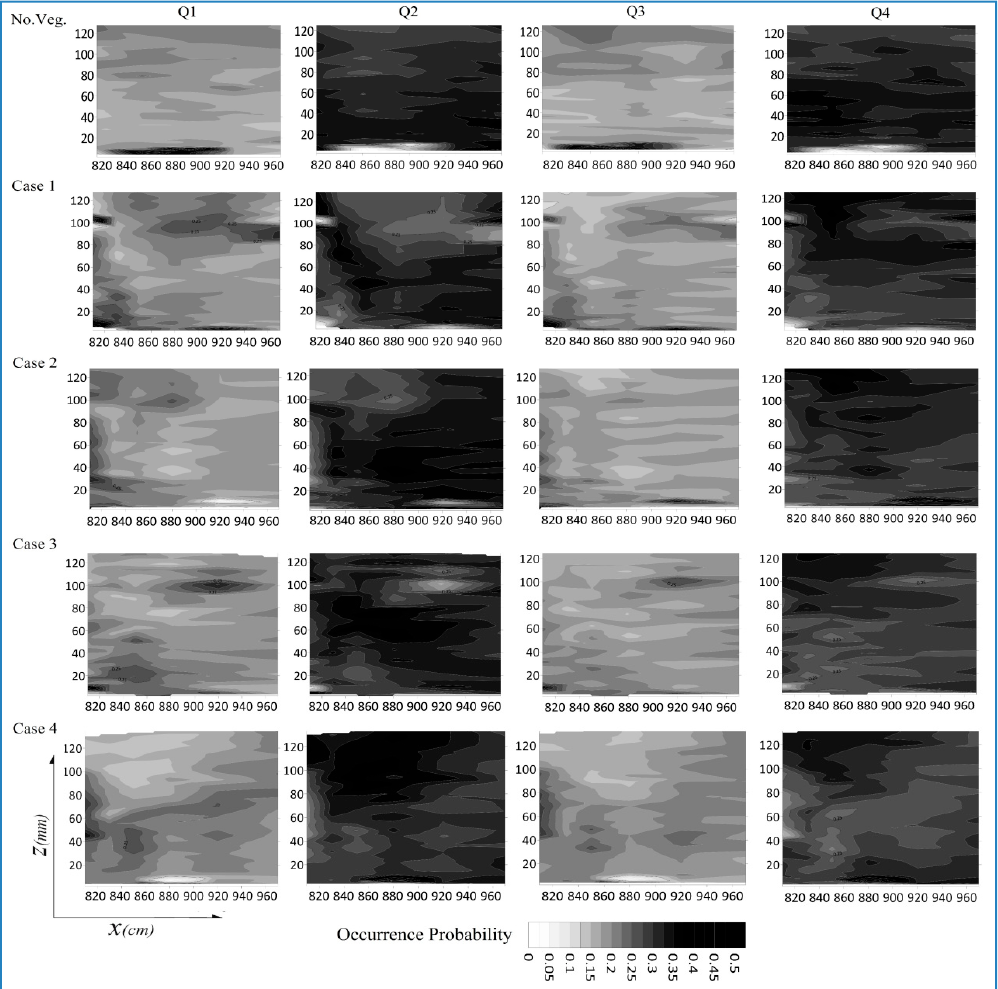
Figure 6. Probability of occurrence of quadrant classes behind the patch; the end of the patch is located at x = 800. The height of the patches is 105 ± 5 mm, and the values are shown up to level of the maximum domain of ADV capability ( ~ 140 mm).